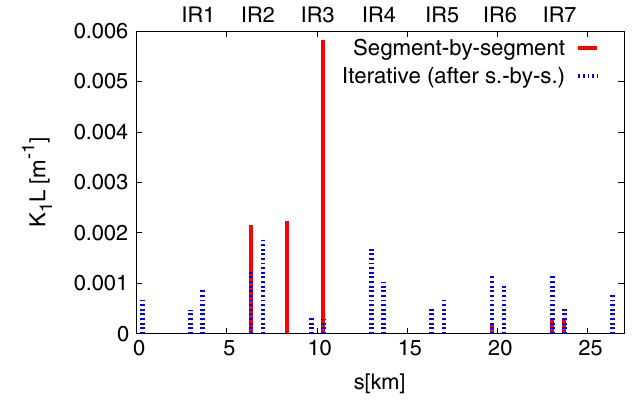
FIG. 9. (Color) Integrated error distribution as obtained by the segment-by-segment and the iterative